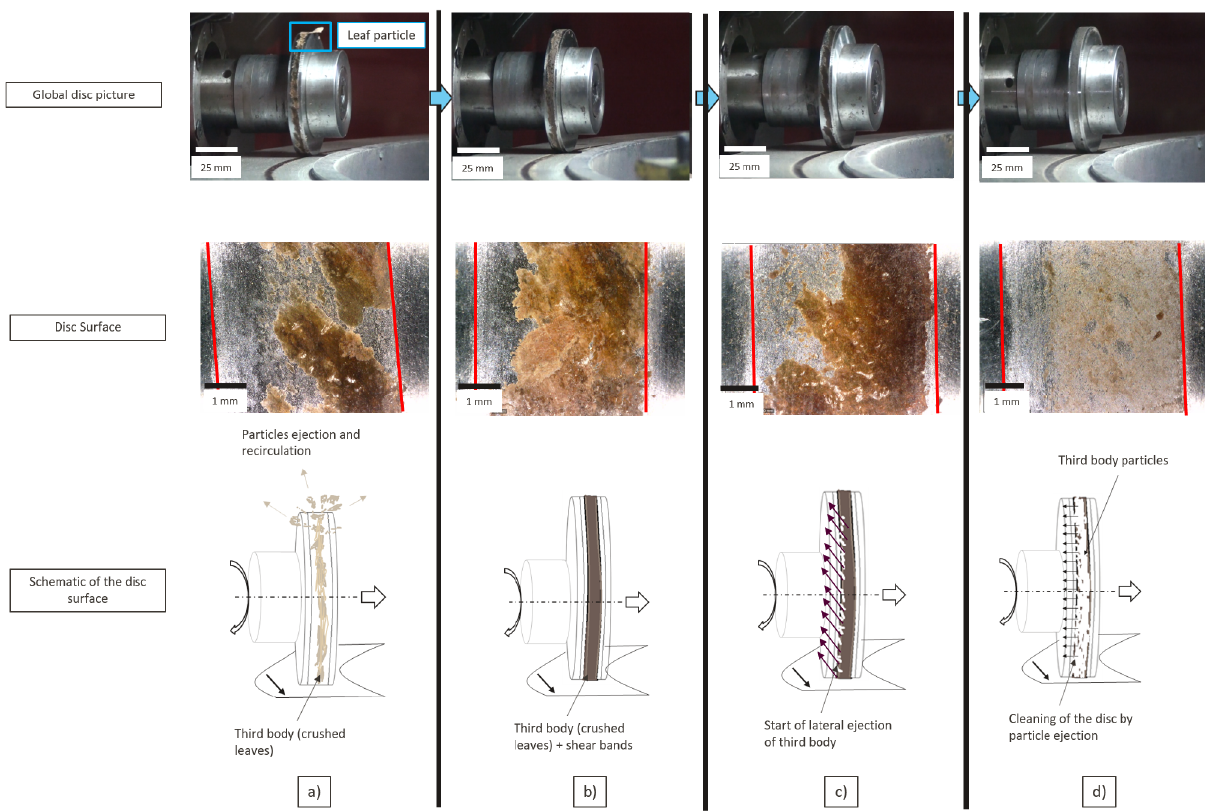
Fig. 21. Characteristic images and diagrams of the disc surface, slip rate: 1 % , RH: 50 %